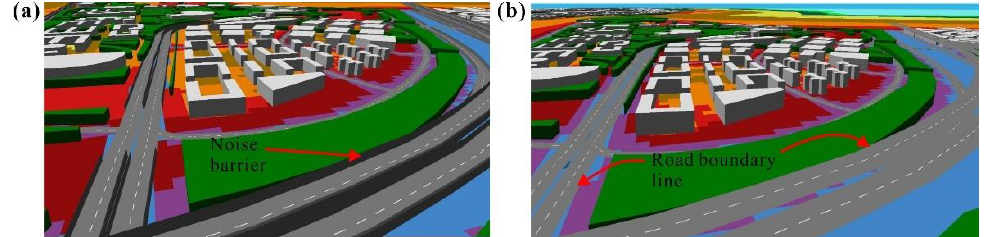
Figure 5. Comparison of three-dimensional noise maps of the small area near Guangzhou University in the University Town. ( a ) With noise barriers; ( b ) without noise barriers.